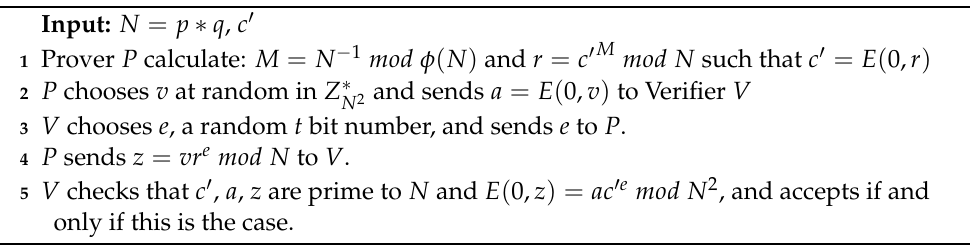
Algorithm A1: Protocol for proving c (cid:48) is an encryption of